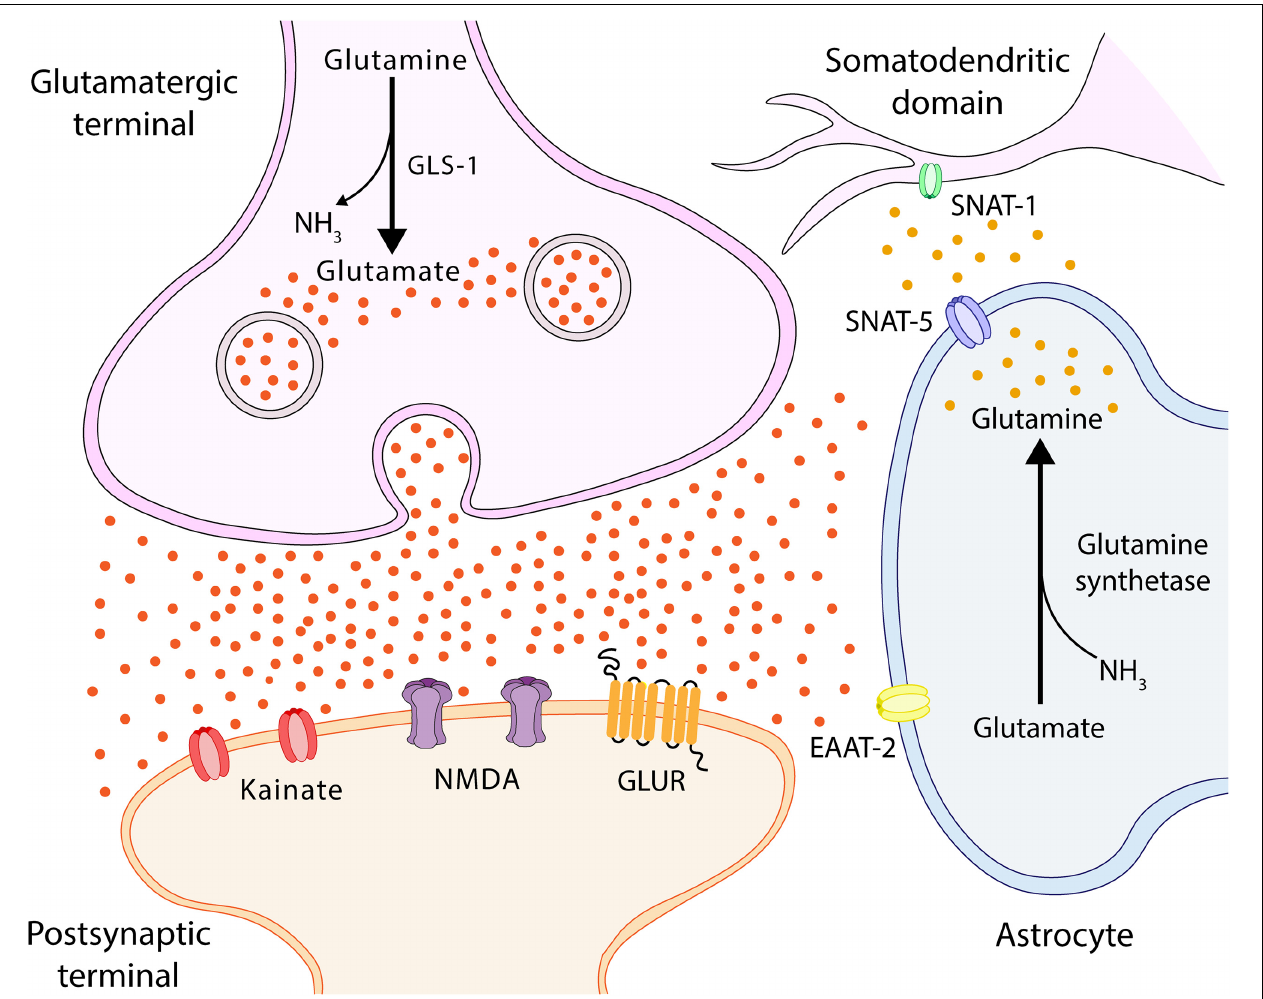
FIGURE 4 | Glutamate-glutamine cycle. Ammonia from the blood is neutralized in the astrocyte via a reaction with glutamate (Glu), which uses glutamine synthetase to form glutamine (Gln). Gln is transported by SNAT-5 to the extracellular environment, where it can then be transported to the cerebrospinal fluid (CSF) or transferred to neurons by SNAT-1, located in the somatodendritic domain (Melone, 2004; Conti and Melone, 2006). In the neuron, Gln is degraded by phosphate-activated glutaminase (GLS-1) into Glu and ammonia. Glu feeds the neurotransmitter pool and is released into the synaptic cleft, interacting with Glu receptors located in both synapses and astrocytes. SNAT-1, neuronal glutamine transporter; SNAT-5, astrocytic glutamine transporter-5; and EAAT, excitatory amino acid